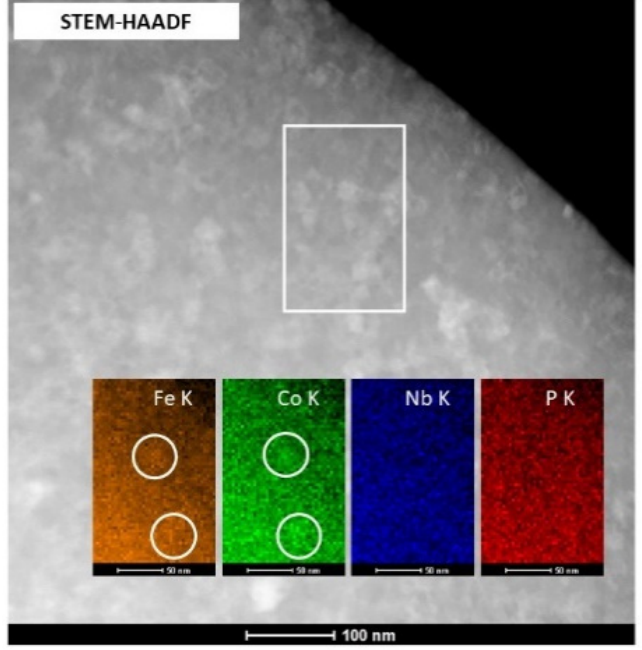
Figure 10. STEM-HAADF image with elemental mapping of Fe 69.5 Co 5 Nb 5 B 8.5 P 2 .